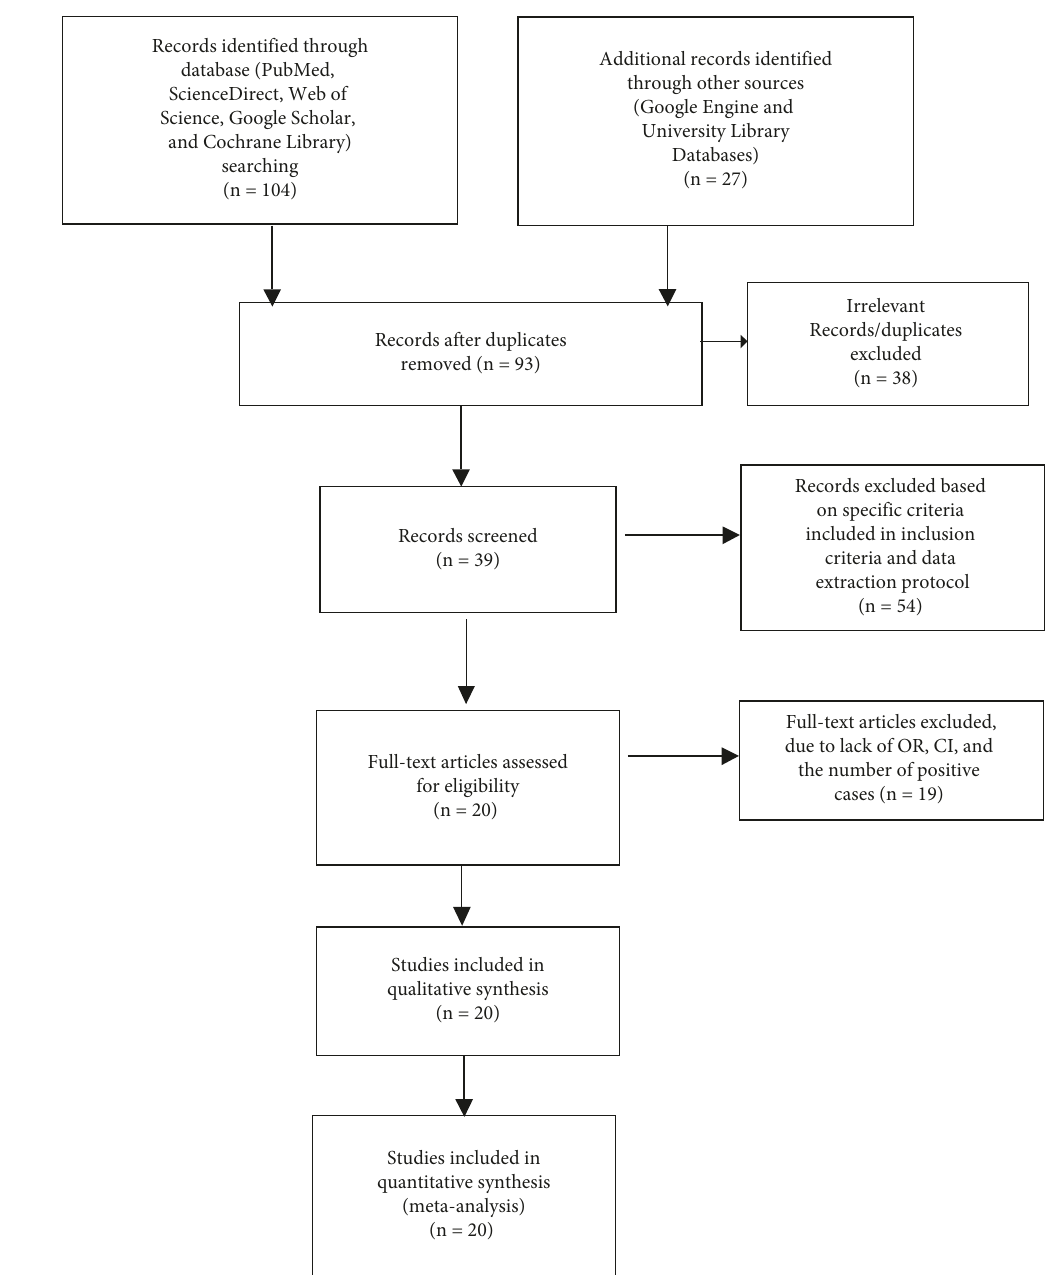
Figure 1: PRISMA 2009 flow diagram of eligible